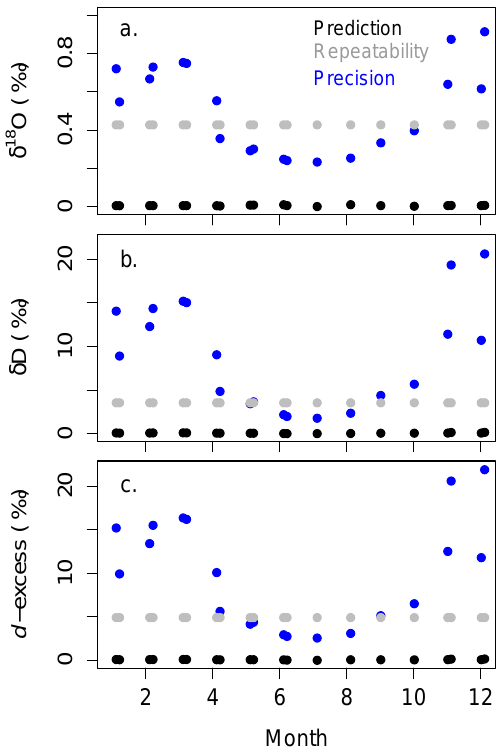
Figure 9. Gulper (Summit) mass-weighted monthly means of (a) δ 18 O, (b) δ D, and (c) deuterium excess in water vapor for 2012 (green), 2013 (red), and 2014 (blue). All monthly means represent >20 days of sampling except for the October 2012 and June 2013 means, which represent 16 and 11 days of sampling, respectively. Data are from the 40m inlet on the instrument tower. Shading rep- resents 1 σ deviations. Monthly mean Summit surface snow values from 2013 (black, with vertical lines representing standard devi- ations) are plotted for comparison and offset by (a) − 10‰ and (b) − 80‰, as an approximation to equilibrium fractionation.